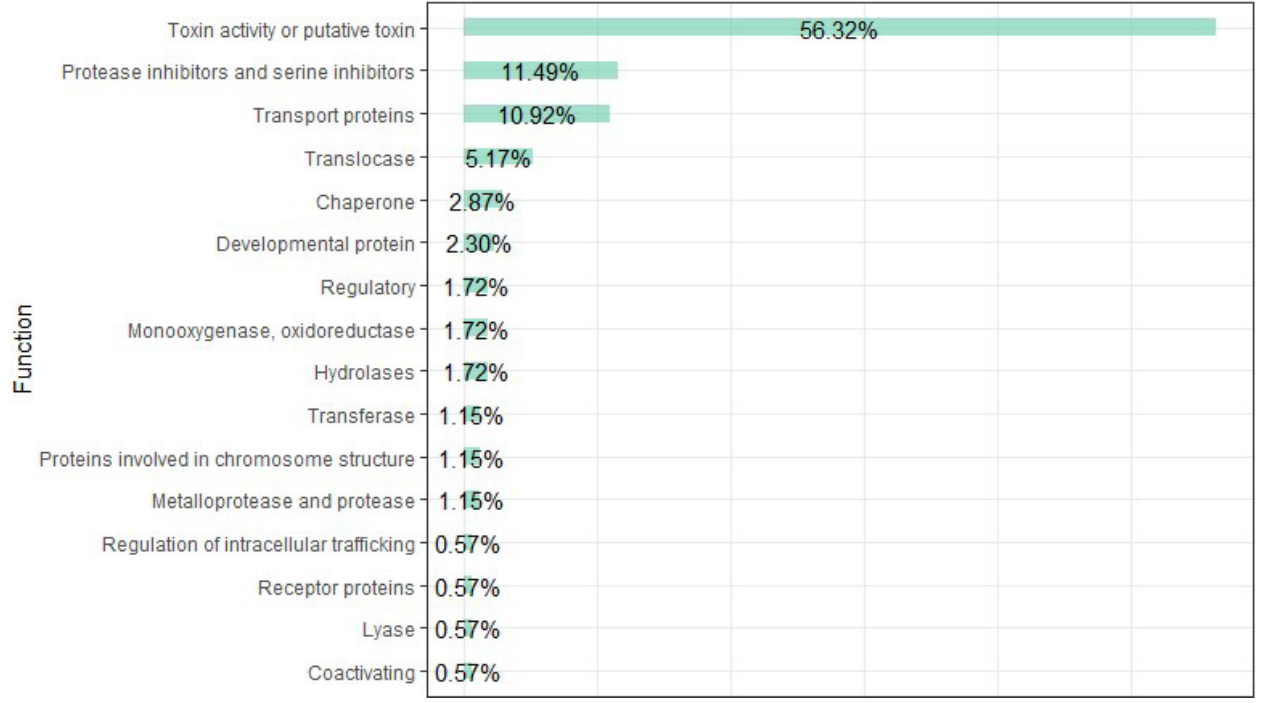
Figure 4. Classification of Phonotimpus pennimani transcripts according to their function (as reported in NCBI and